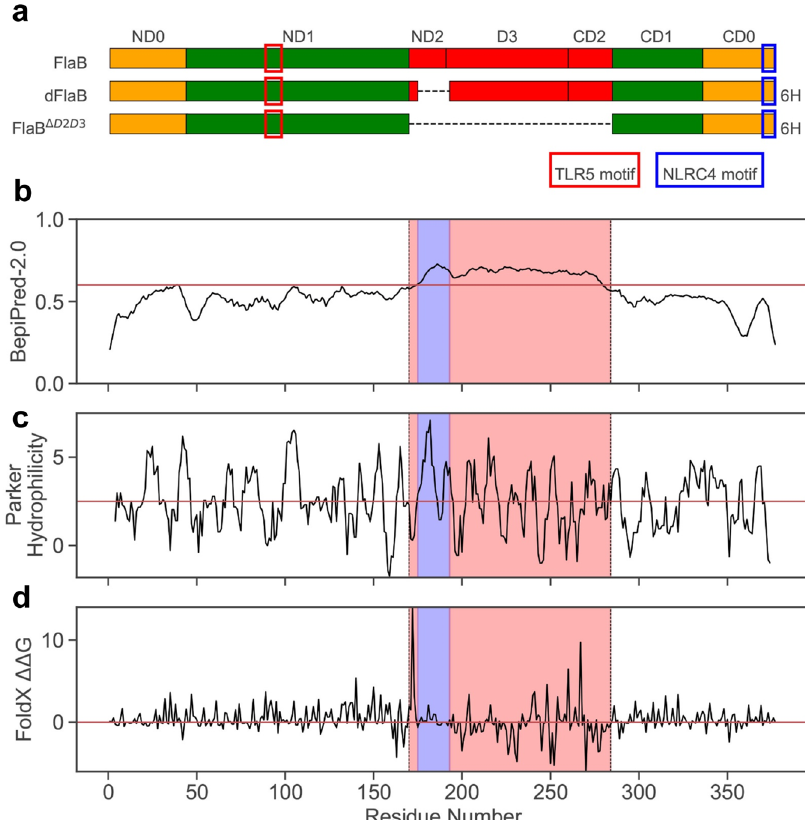
Fig. 1 Development of deimmunized fl agellins. a Schematic view of deimmunized FlaB variants. Wild type Vibrio vulni fi cus FlaB consists of conserved N- and C-terminal domains required for fl agellum biogenesis. dFlaB and FlaB Δ D2D3 were deimmunized by deleting potential B-cell epitopes in ND2, D3, and CD2, where variability among different bacterial genus and species. b BepiPred-2.0 predicted ND2 to CD2 domains being most immunogenic. c The Parker hydrophilicity predicted that the most of ND2 domain may also be immunogenic. d In silico alanine scanning by FoldX additionally identi fi ed residues in little interactions with other regions (near zero). Based on these three metrics, we selected a linear region of 19 amino acids (175 SYQAEEGKDKNWNVAAGDN 193; shaded in blue) for deimmunization. The red box in ND1 represents TLR5 binding motif while blue box in CD0 represents NLRC4 binding motif, respectively. The 6H represented 6xHis-Tag for puri fi cation of recombinant dFlaB and FlaB Δ D2D3